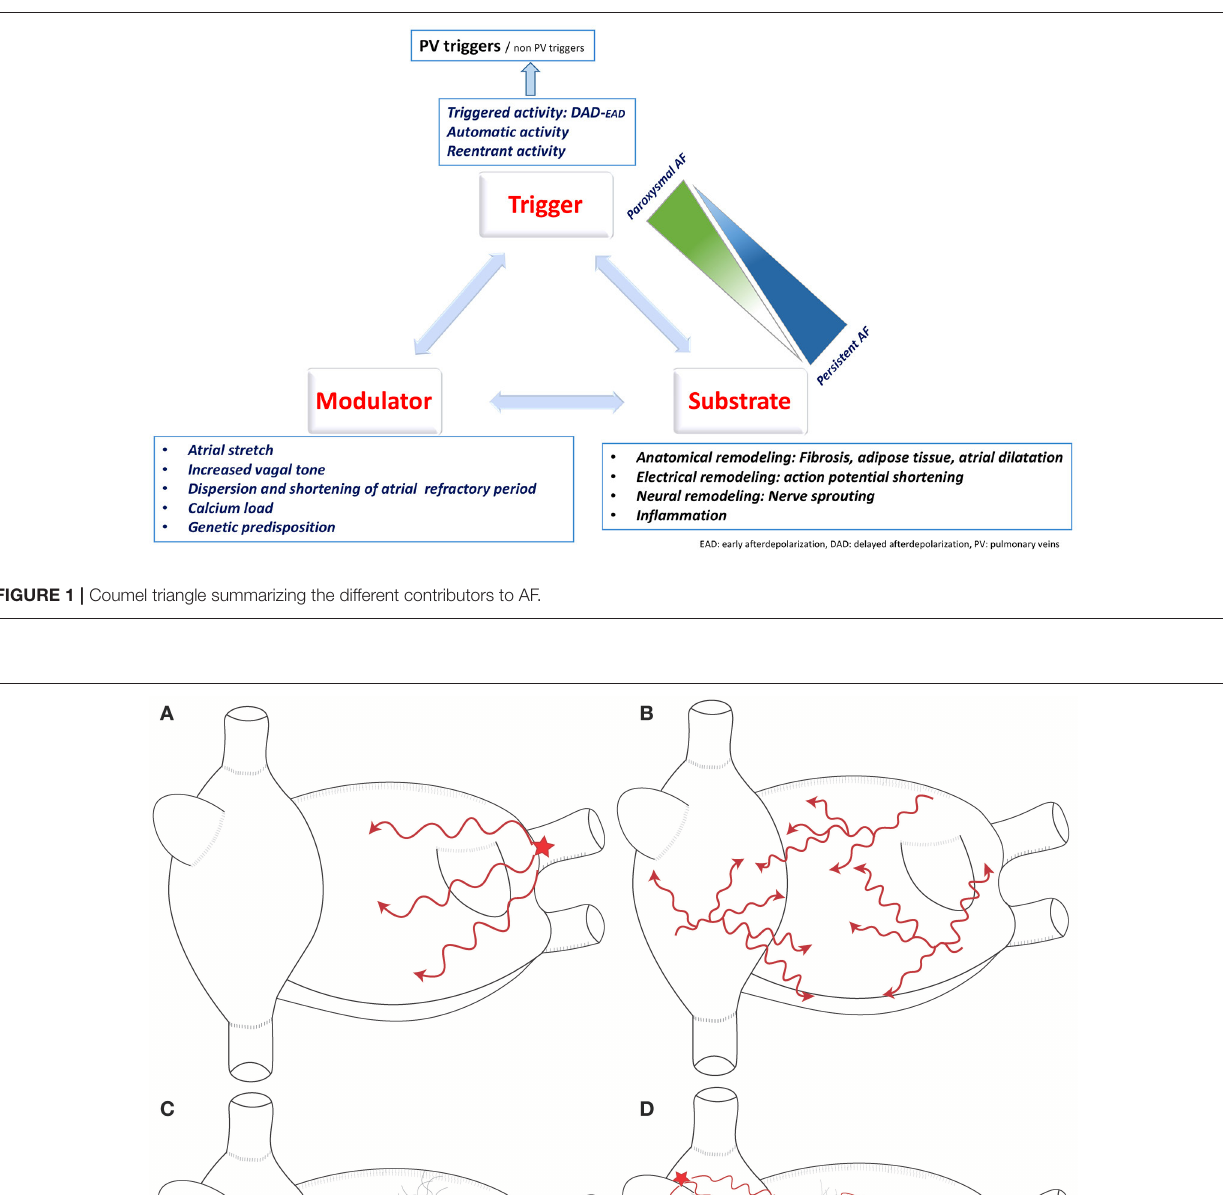
Frontiers in Physiology | www.frontiersin.org